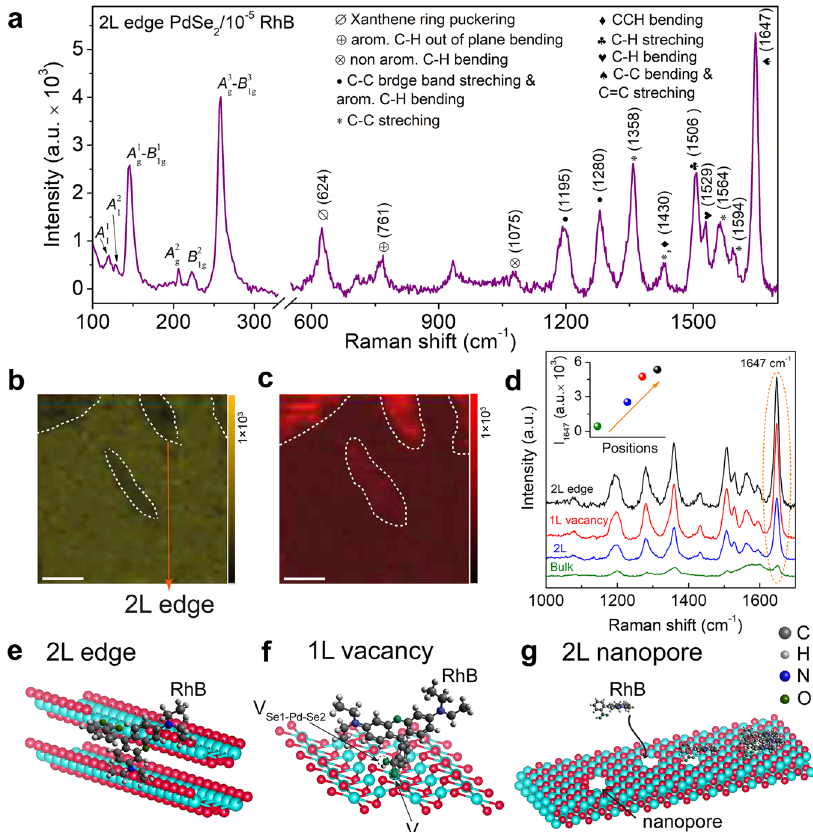
Fig. 5 SERS enhancement at the dendritic PdSe 2 . a Raman spectrum of 10 − 5 M RhB on the intrinsic edge of 2L PdSe 2 . b , c The Raman intensity mapping of 258 cm − 1 peak of PdSe 2 and 1647 cm − 1 peak of rhodamine B, respectively. Scale bar is 2 μ m. d Stacked Raman spectra of 10 − 5 M RhB on different spots (2L edge, 1L vacancy, 2L surface, bulk). Inset shows the position-dependent Raman intensity (I 1647 ). Proposed mechanism of adsorption of RhB molecules at three different sites: e 2L edge, f 1L vacancy and g 2L